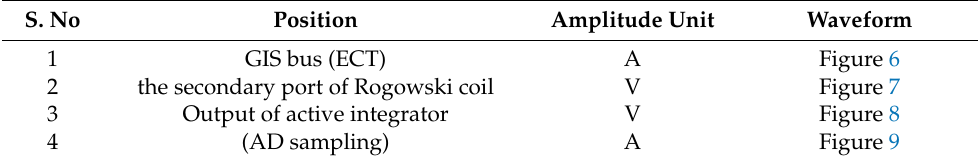
Table 5. Transient VFTC at different electronic current transformer (ECT) component points (single). S.